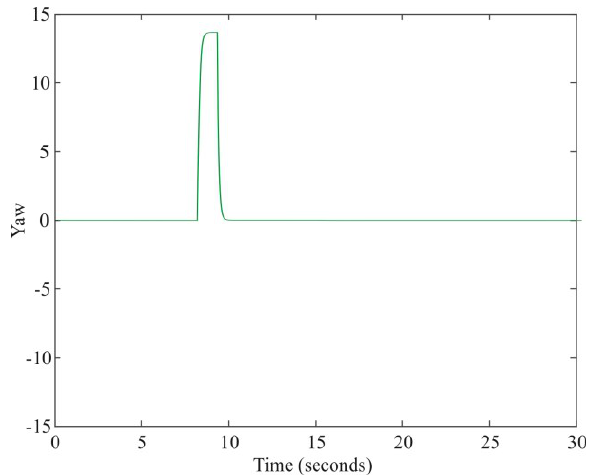
Fig. 14. The response of the object using a cascade controller (direction of